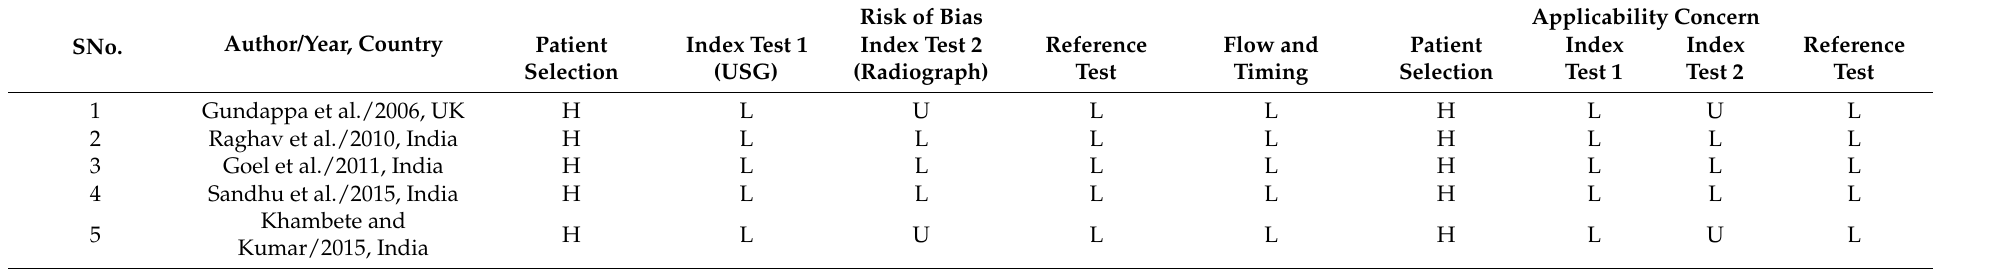
Table 3. Summary of Quality Assessment of